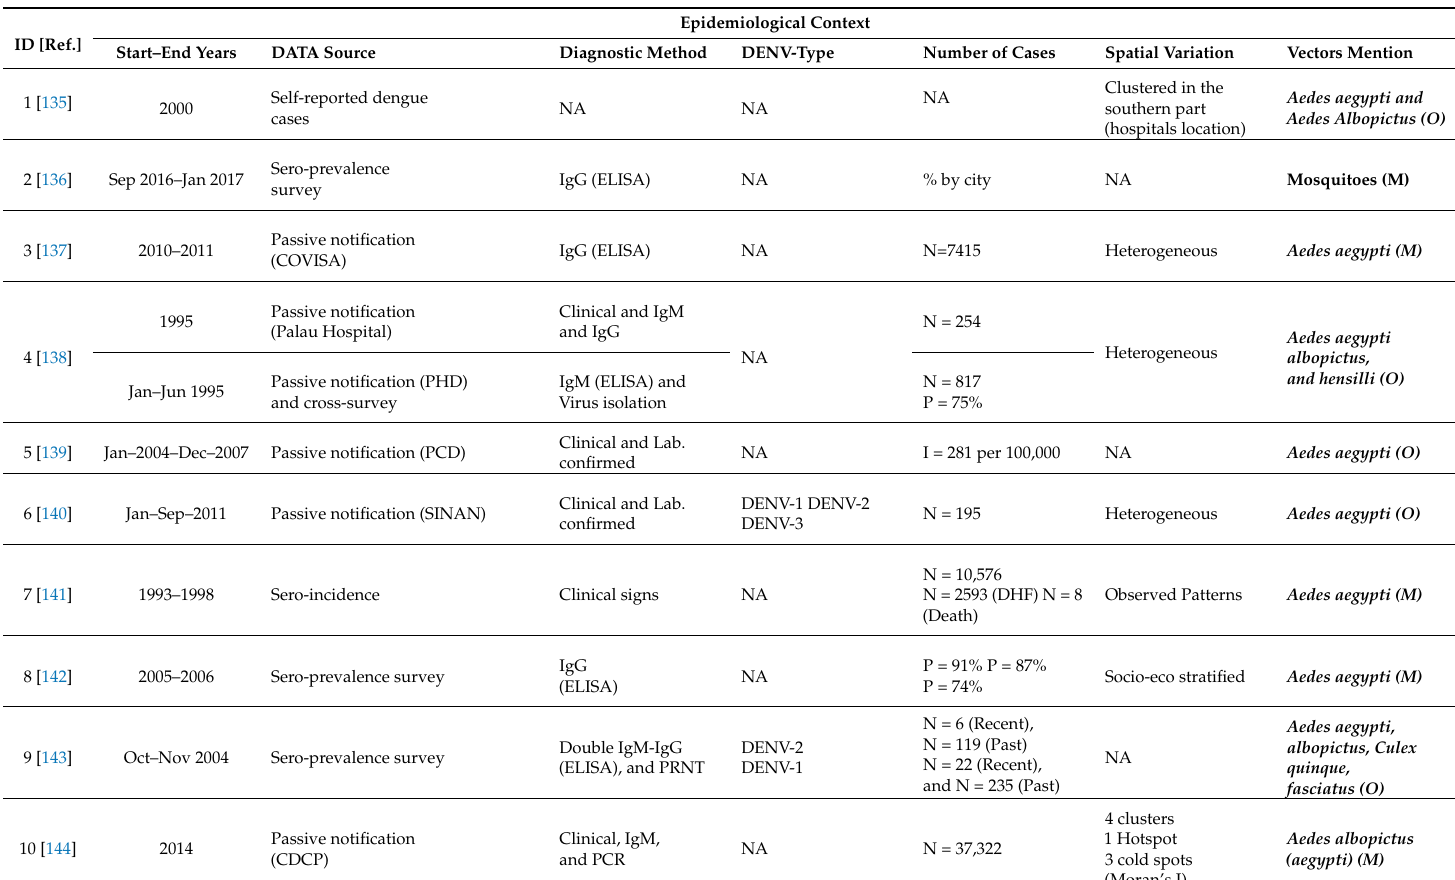
Table A2. Data extracted from the 78 articles on the epidemiological context (time-span of the outbreak or of the serosurvey, data provider, method used to identify dengue virus, number of cases ([n]) or incidence (I) or prevalence (P), spatial distribution of the dengue occurrences). In last column, we indicate if vectors are only mentioned (M) or observed (O) in the